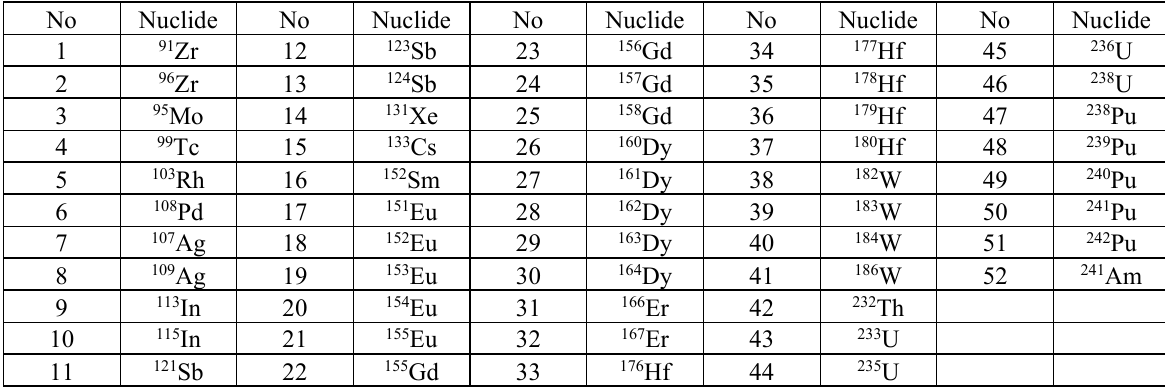
Table I. List of nuclides including subgroup